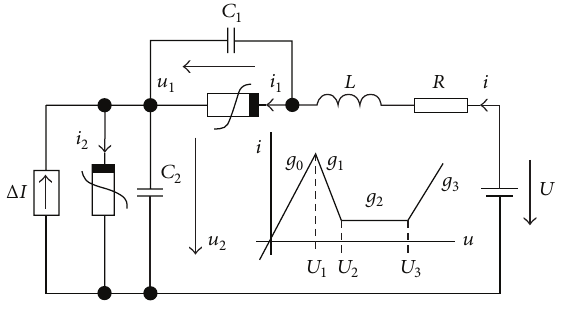
Figure 1: Ternary memory circuit.